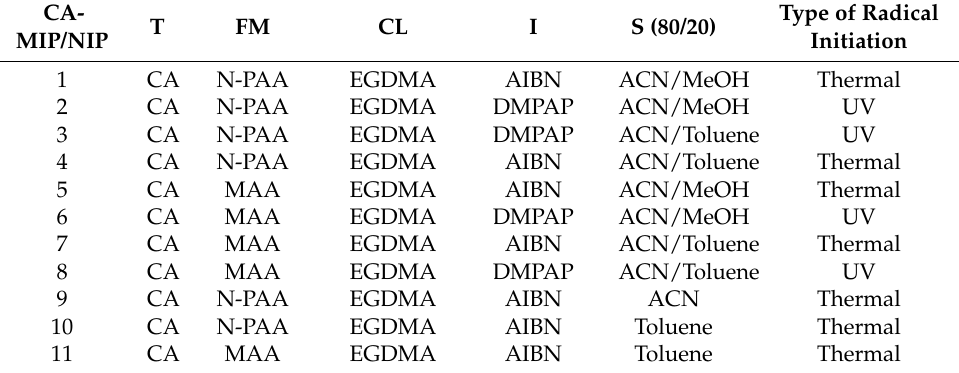
Table 1. Condition synthesis of 11 couples of